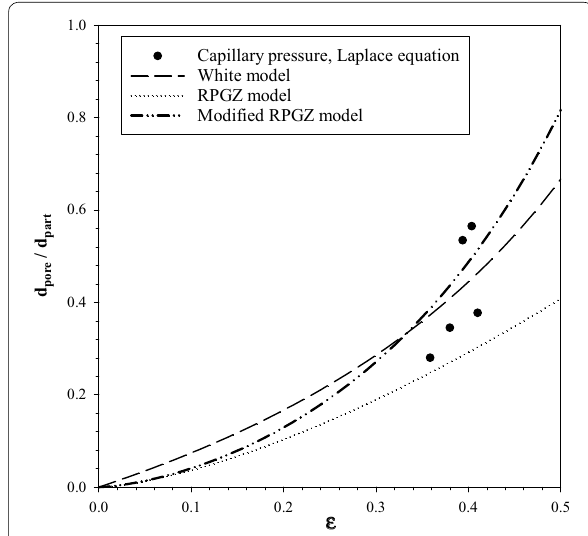
Fig. 3 Comparison of pore diameters from fit of capillary pressure data to pore diameters calculated from mean particle